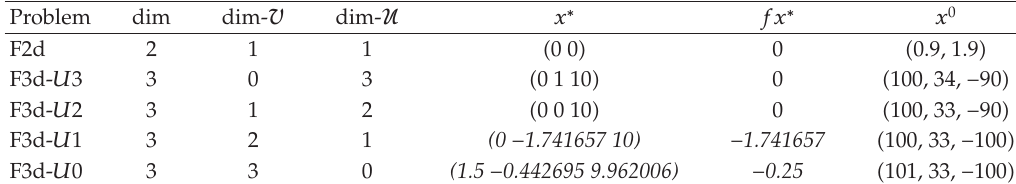
Table 1: Problem data.